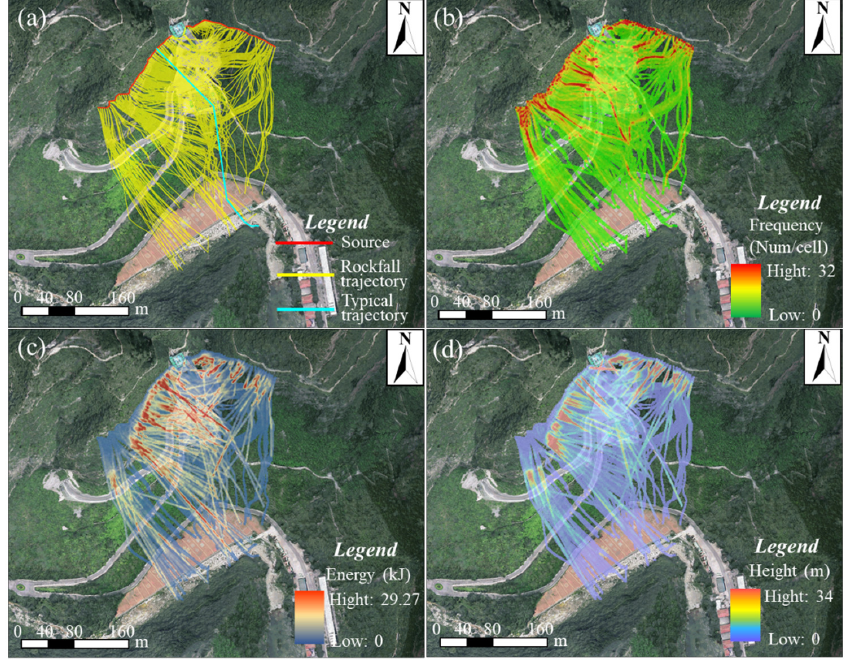
Figure 20. Spatial distribution of disaster-causing factors in the scenic spot of Sky City. ( a ) Rockfall trajectory. ( b ) Rockfall frequency. ( c ) Rockfall kinematic energy. ( d ) Rockfall bounce height.